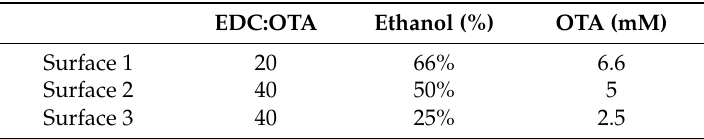
Table 1. Different OTA immobilization